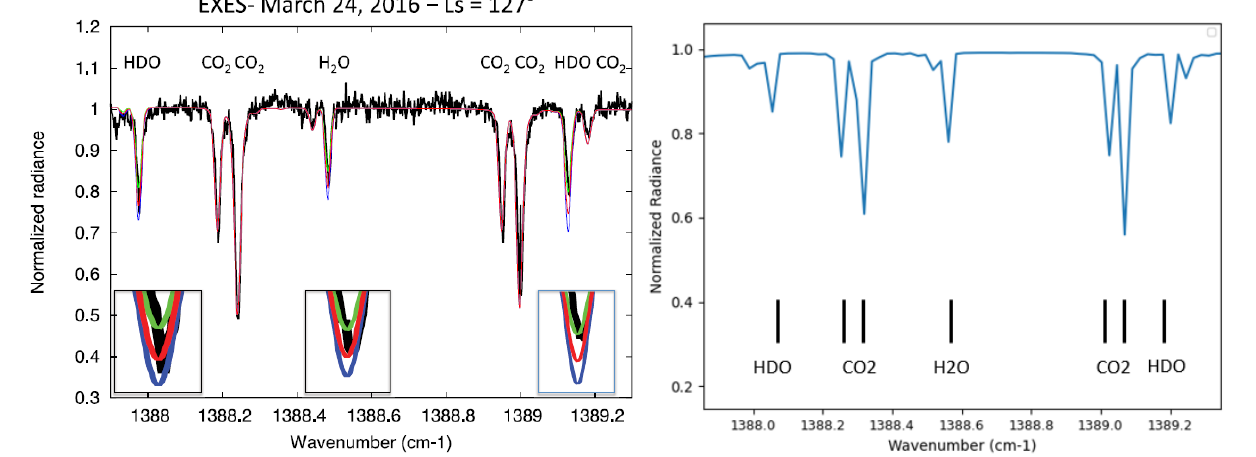
Figure 15. Comparison between the simulation and EXES data at 1388–1389.2 cm − 1 ([34]). ( Left panel ) EXES data, at 1388–1389.2 cm − 1 , with the corresponding line identification. The line identification is identical in both figures. Green: H 2 O = 250 ppm. HDO = 400 ppb. Red: H 2 O = 375 ppm. HDO = 550 ppb. Blue: H 2 O = 500 ppm. HDO = 700 ppb. ( Right panel ) Normalized radiance simulation with the corresponding line identification. There is a discrepancy in the depth of the H 2 O and HDO lines between simulation and observations. This means that the simulated opacities for HDO and H 2 O transitions assume abundances that disagree with the abundances derived by Encrenaz et al.